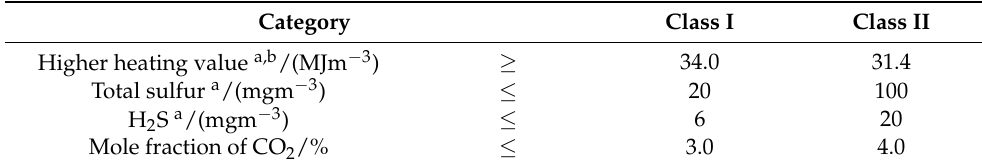
Table 1. Quality requirements for different types of natural